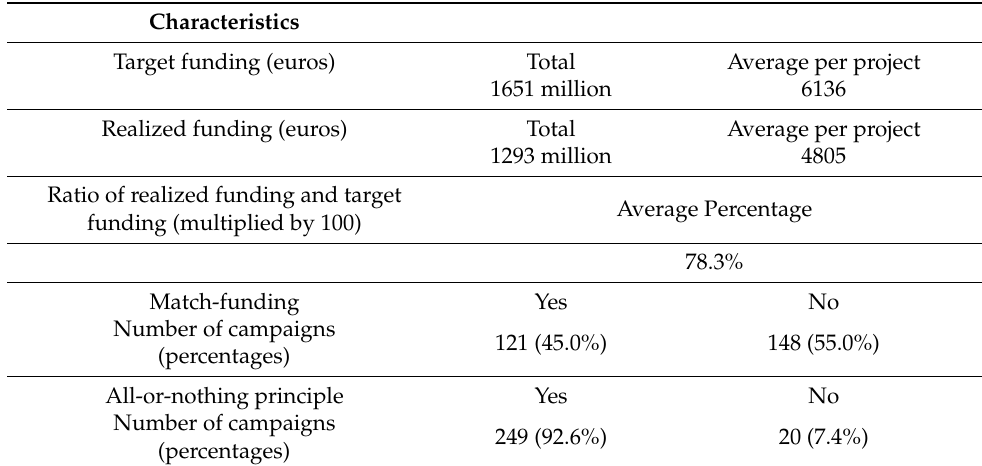
Table 1. Characteristics of 269 civic crowdfunding campaigns in data